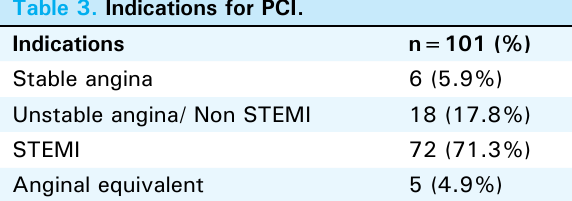
Table 3. Indications for PCI.